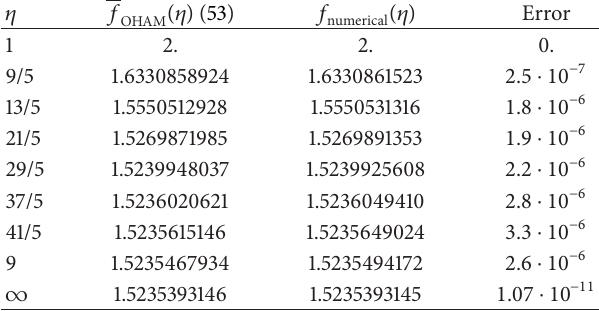
Table 7: Comparison between the derivative 𝑓 (51) and numerical results for 𝛾 = 1 and 𝑆 = −2 (error = |𝑓 (𝜂)| ). 𝑓 󸀠 numerical